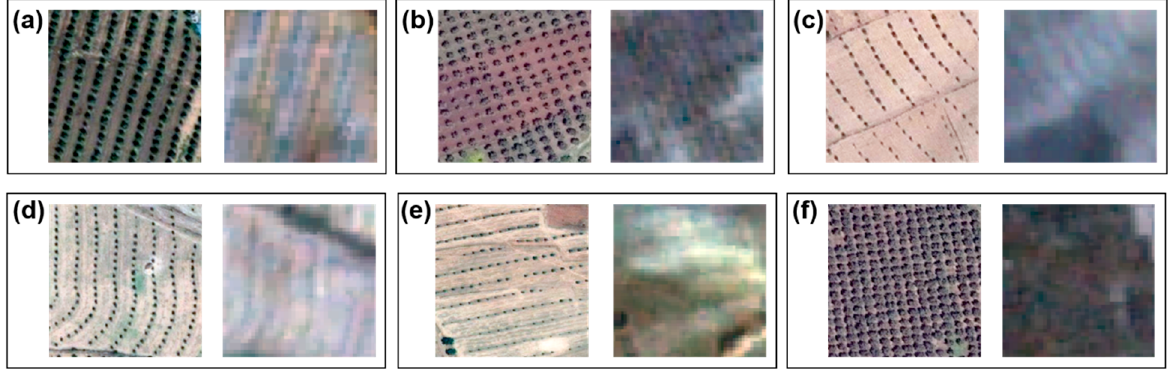
Figure 13. Cases when olive orchards are visible and invisible on Planet imagery (DG: left, Planet: right); ( a , b ) olives with large crowns are visible on Planet imagery; ( c , d ) olives with small crowns but narrow spacing are visible on Planet imagery; ( e ) olives with small crowns with large spacing are invisible on Planet imagery; ( f ) olives with large crowns and close spacing within and across rows are invisible on Planet imagery.